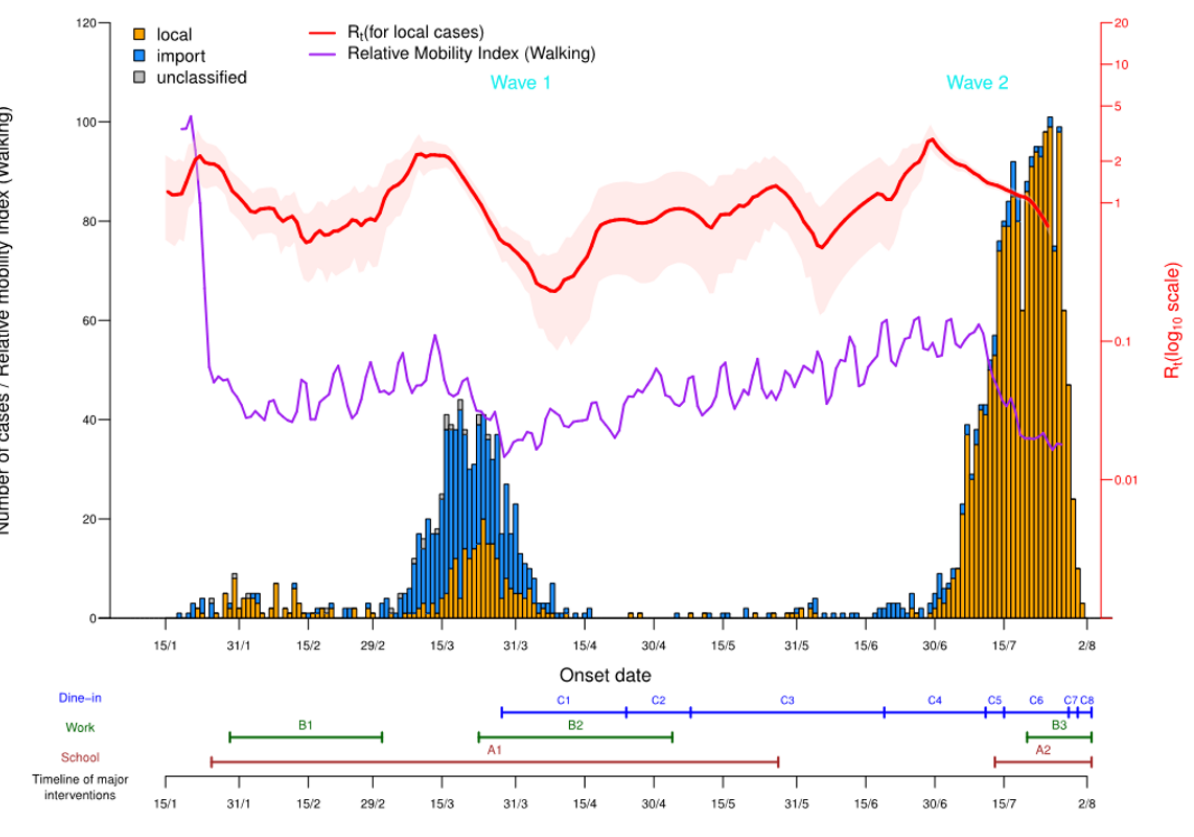
Figure 1. Epidemic curve of COVID-19 and timeline for major interventions in Hong Kong. A1: School closure, January 25-May 26, 2020. A2: School closure, July 13, 2020 to ongoing as of August 2, 2020. B1: The government spearheaded work-from-home arrangements, January 29-March 1,